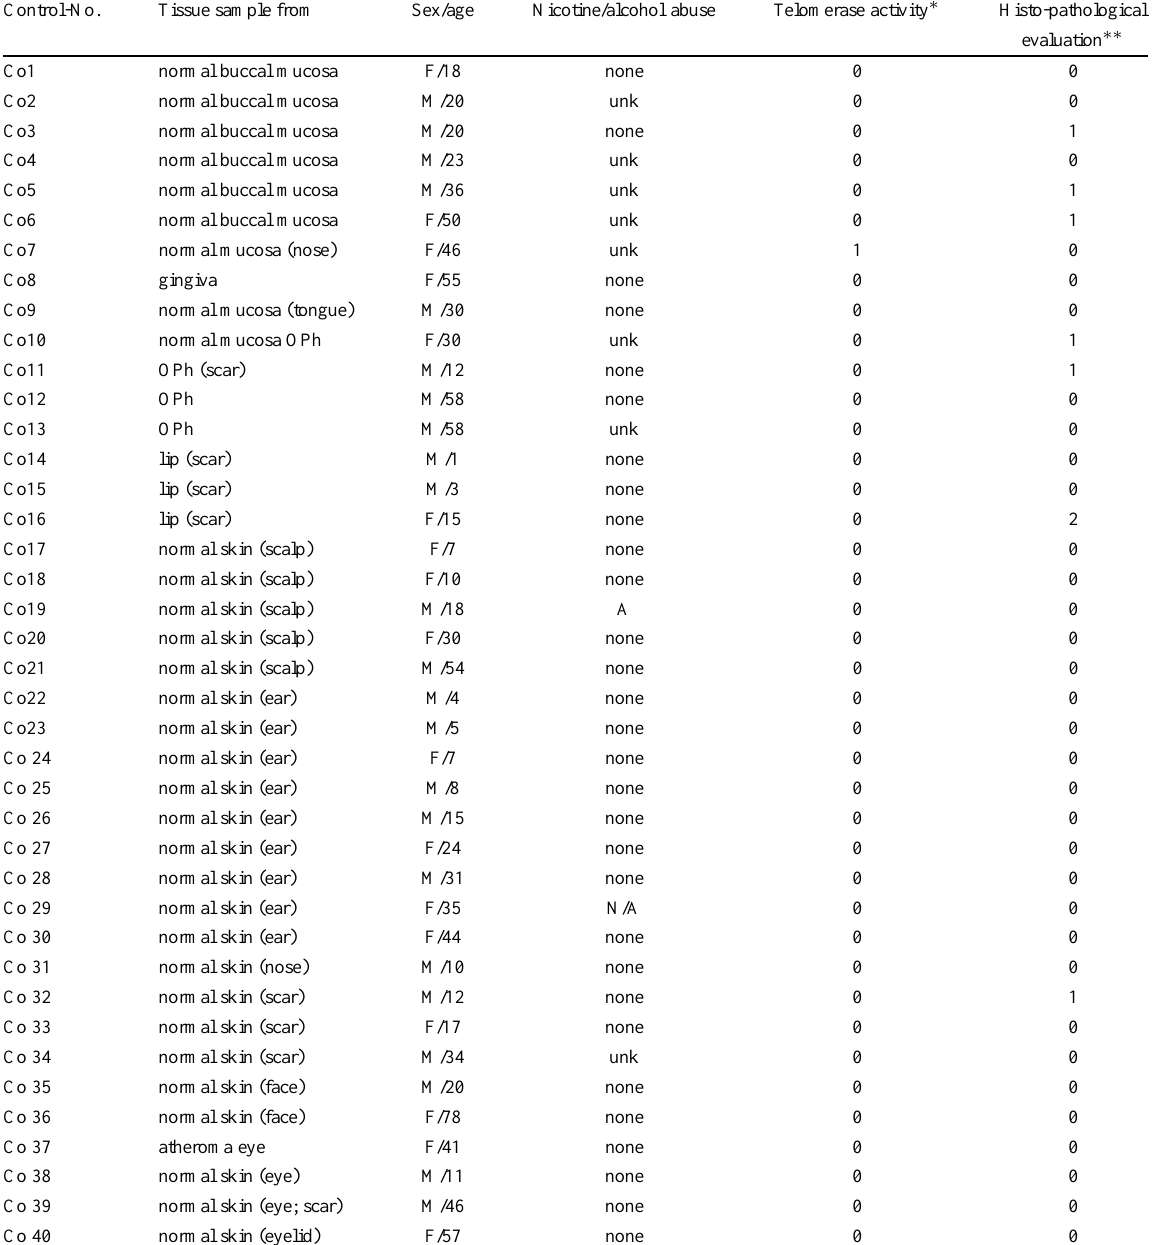
Telomerase levels in normal tissues from 40 patients without tumours for determination of cut-off value: tissues and patients’ data